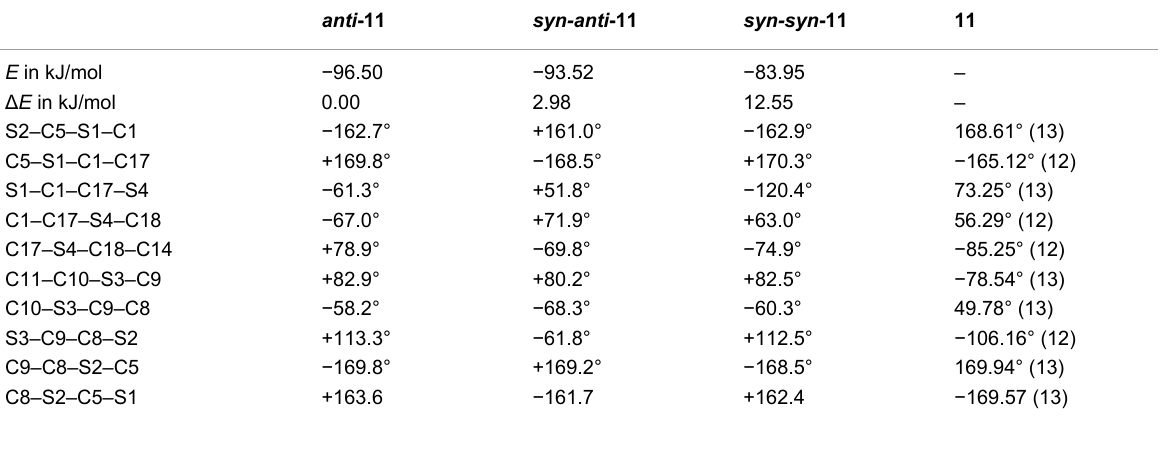
Table 2: Selected computed dihedral angles (deg) of anti -11 , syn-anti -11 , and syn-syn -11 and those of 11 derived from the X-ray